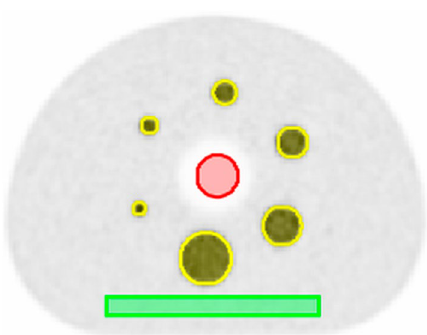
Fig. 1 Central slice of a 600 s acquisition with 8:1 SBR of the IQ phantom. The VOIs of the background (green), spheres (yellow) and lung (red) are used to extract the voxel data for contrast and noise